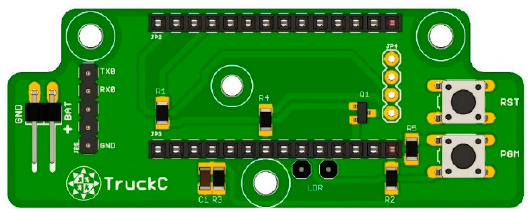
Figure 4. Sensor node 3D view of the PCB.